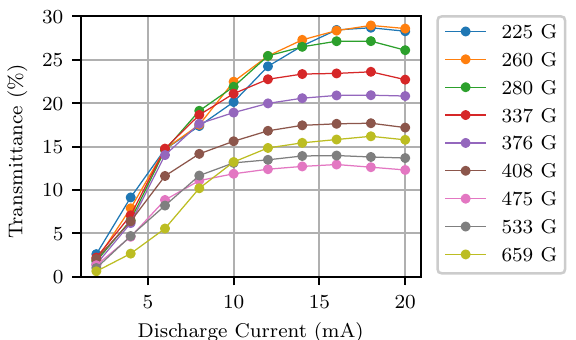
Figure 3. The peak transmittances at different magnetic fields versus various the discharge current of the HCL. The maximum transmittance is 29% at the discharge current of 18 mA and the magnetic field of 260